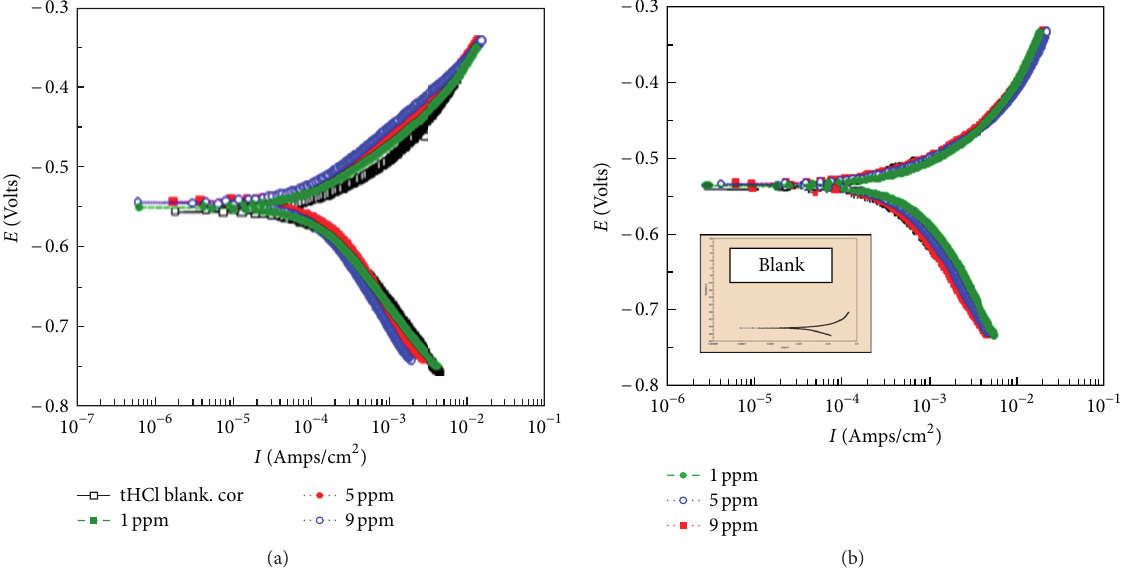
F 6: Polarisation curves of SPAH for mild steel in (a) 1M HCl and (b) 0.5M H